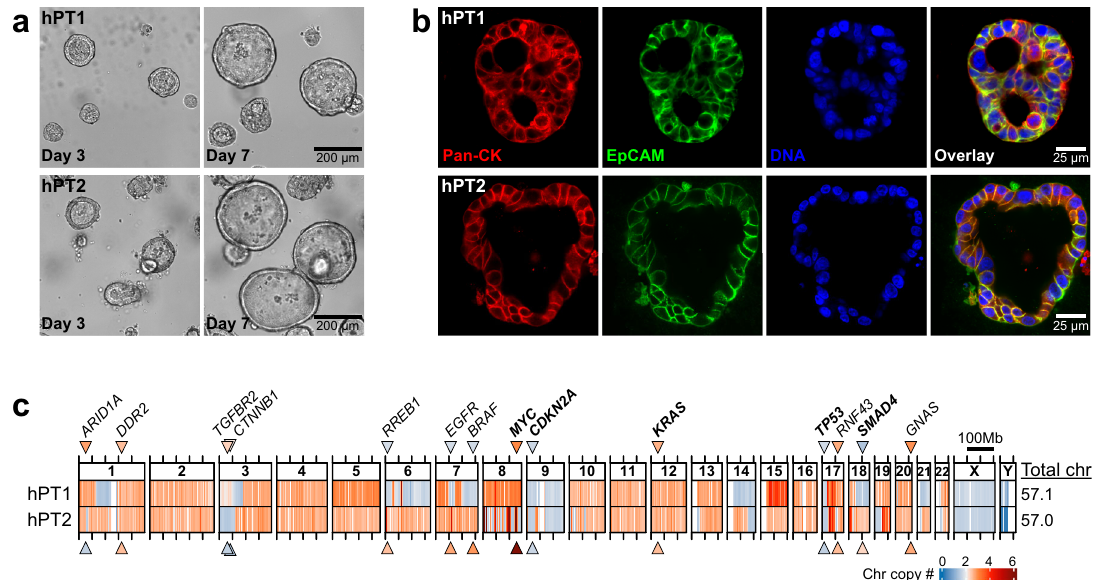
Fig. 1 Chromosome copy number alterations in patient-derived pancreatic ductal adenocarcinoma (PDAC) organoids. a Representative images of primary tumor-derived PDAC organoids, hPT1 and hPT2, from two independent patients, showing the growth of the organoids over 4 days (bar = 200 µm). b Confocal sections of hPT1 and hPT2 organoids immunostained for cytokeratin (red) and EpCAM (green), both are markers of epithelial and PDAC cells (bar = 25 µm). c Genomic DNA of passage 3 of hPT1 and passage 6 of hPT2 was subjected to SNPa,